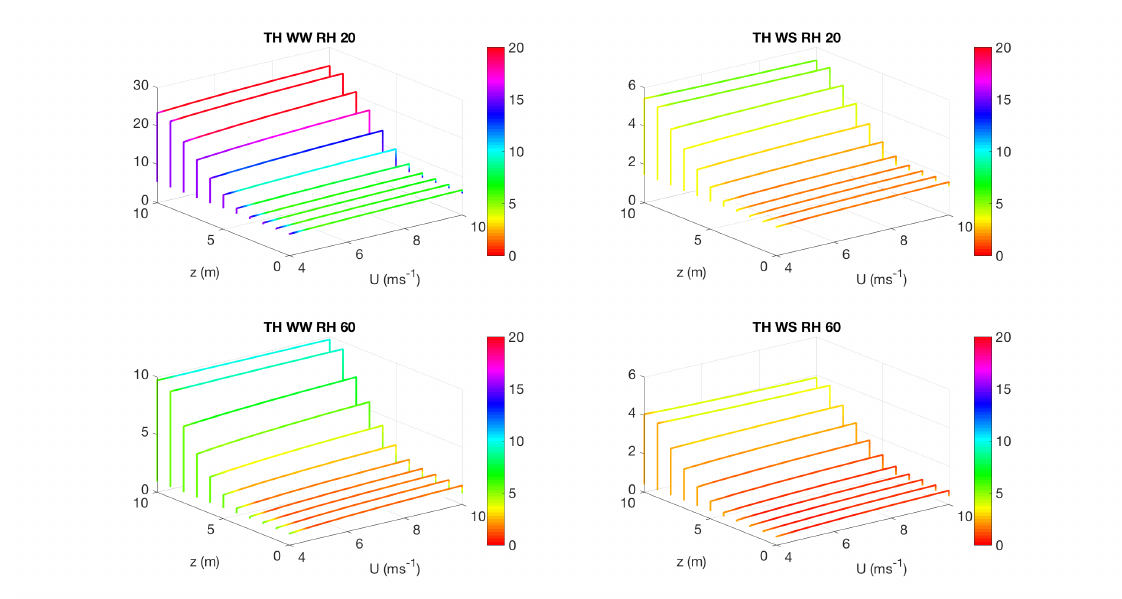
Figure 7. Variations of leaf level transpiration fe (molm − 2 leafs − 1 ) with wind speed U and height z for the top heavy (TH) scenario for the following four cases in high light conditions. WW RH20 means well watered, high evaporative demand; WS RH20 means water stressed, high evaporative demand; WW RH60 means well watered, low evaporative demand; WS RH60 means water stressed, low evaporative demand. Color bars show fe multiplied by 1000, x axes show wind speed U in ms − 1 and y axes show canopy height z in m.